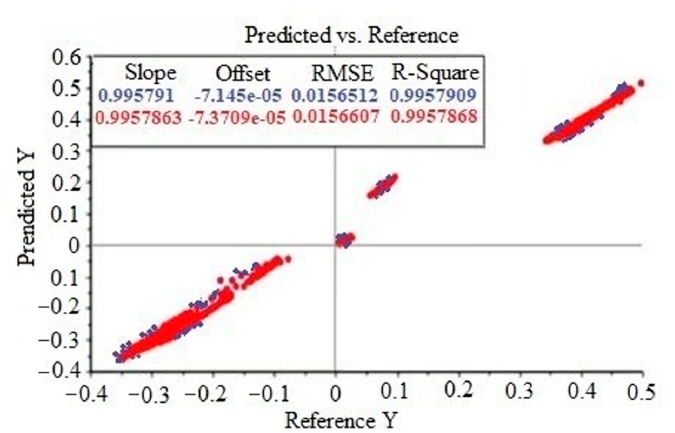
Figure 5. The R 2 and RMSE of the raw NIR spectra of Ophiopogon japonicus , where blue is the actual value and red is the validation value.